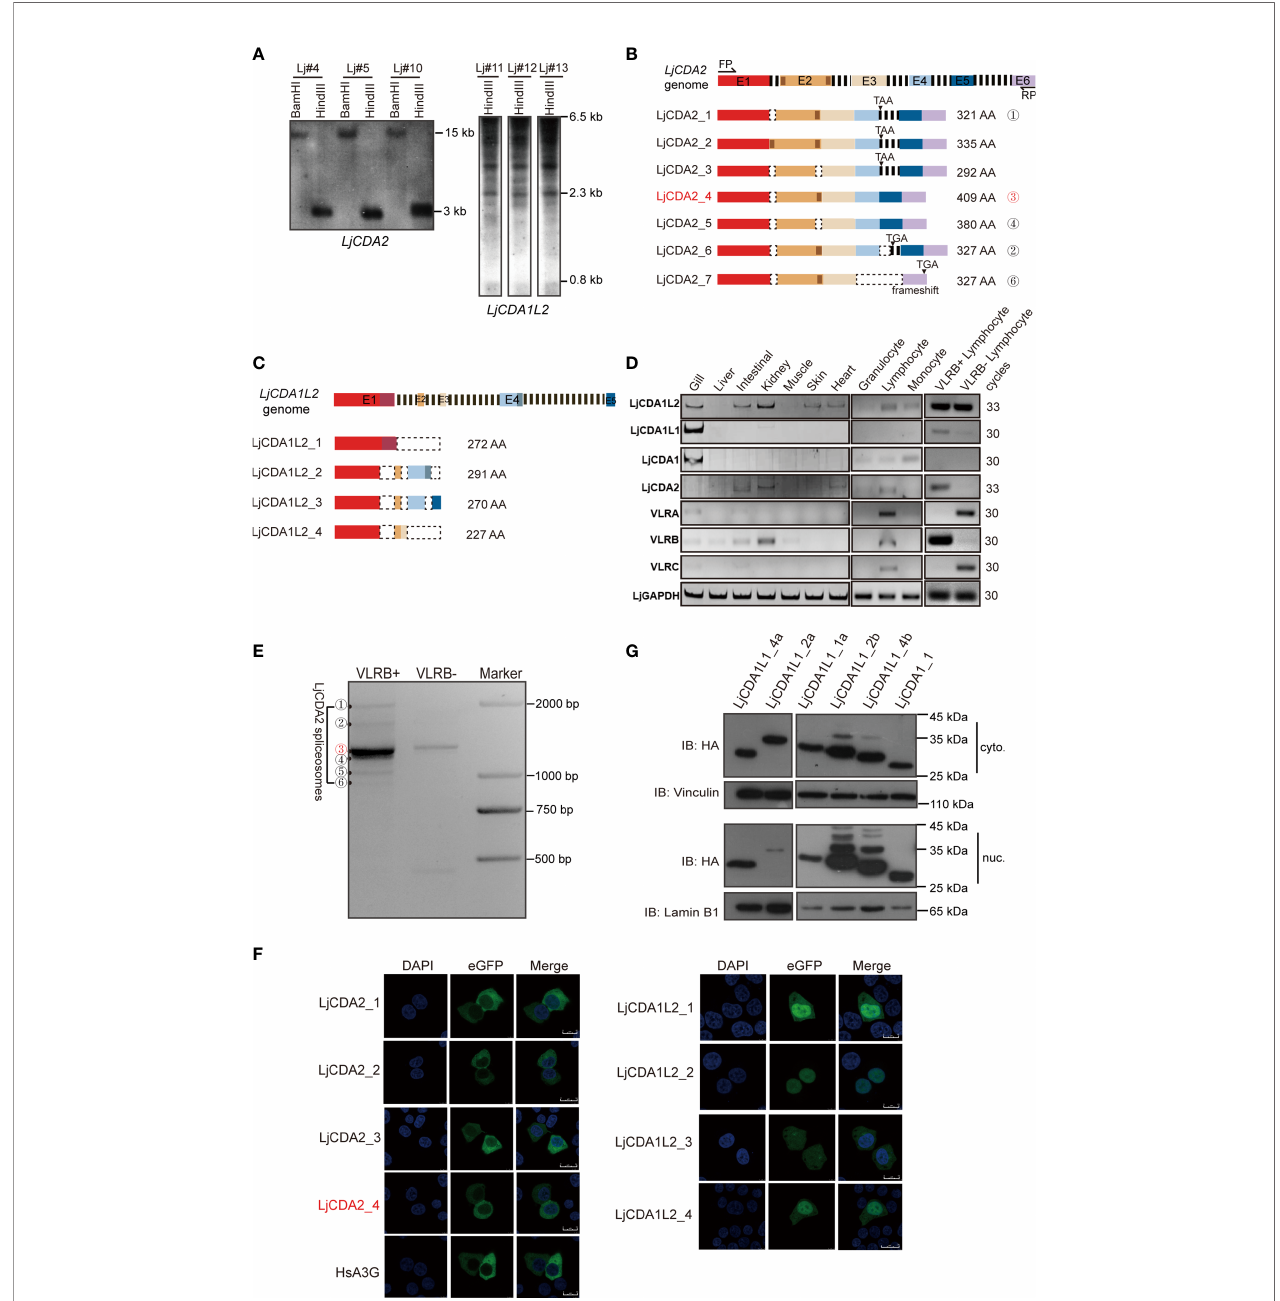
FIGURE 2 | Functional implications of distinct AID/APOBEC genes in lamprey. (A) Southern blot analyses of LjCDA2 and LjCDA1L2 genes. Genomic DNAs were digested by indicated enzymes before transferring to the Hybond N + nylon membrane. Lj#4, Lj#5, and Lj#10 – Lj#13 indicate the individual numbers of Japanese lamprey. (B) Genomic and mRNA spliceosome structures of the lamprey LjCDA2 gene. Colored boxes represent exons (E1 – E6); dashed lines represent introns; dotted boxes correspond to the absent sequences. FP and RP indicate forward and reverse primer. More details are shown in Figure S3A . (C) Genomic and mRNA spliceosome structures of the lamprey LjCDA1L2 gene. Colored boxes represent exons (E1 – E5); dashed lines represent introns; dotted boxes correspond to the absent sequences. More details are shown in Figure S3B . (D) SqRT-PCR to detect the tissue and cell distribution of the lamprey LjAID/APOBEC and LjVLR genes. (E) PCR to detect the alternative splicing variants of LjCDA2 in VLRB-positive and VLRB-negative cells sorted by fl ow cytometry. ① – ⑥ indicate the splicing forms of LjCDA2. (F) Subcellular localization of HsA3G, LjCDA2, and LjCDA1L2 splicing forms in 293T cells detected by confocal microscopy. GFP-tagged HsA3G was used as control. (G) Western blotting to detect the subcellular localization of LjCDA1_1 and LjCDA1L1 proteins in 293T cells. Results of subcellular locations were representative of three independent biological